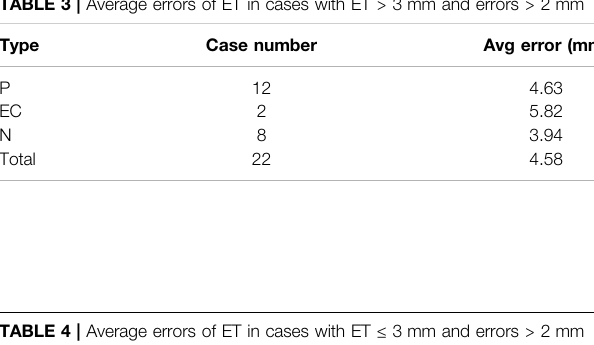
TABLE 4 | Average errors of ET in cases with ET ≤ 3 mm and errors > 2 mm Type